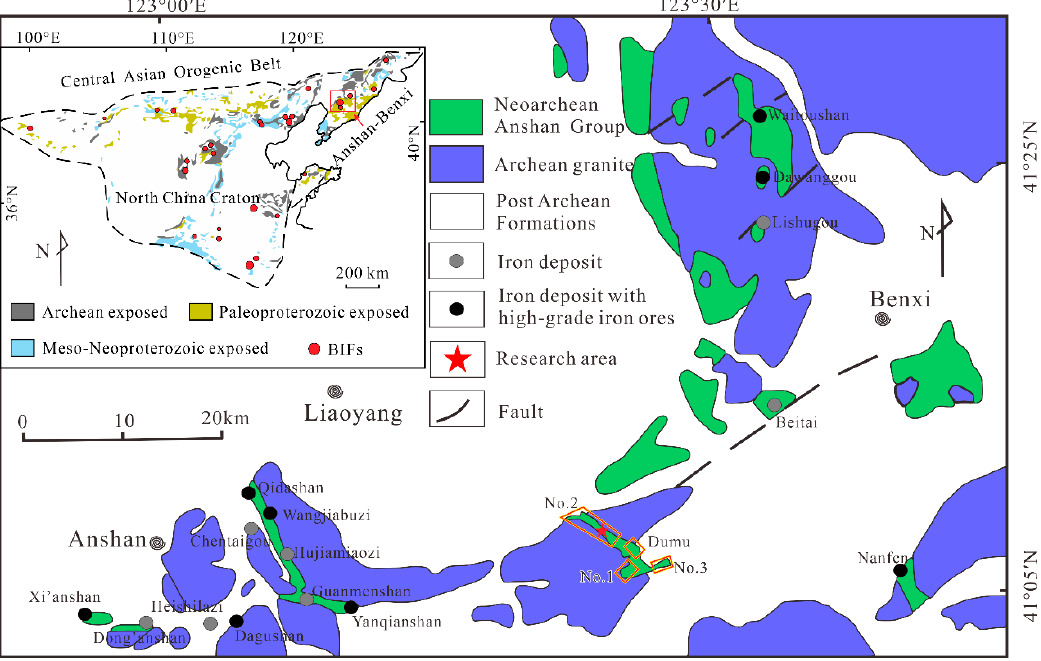
Figure 1. Geological map of the Anshan–Benxi area, Liaoning Province. Modified after [27,45].